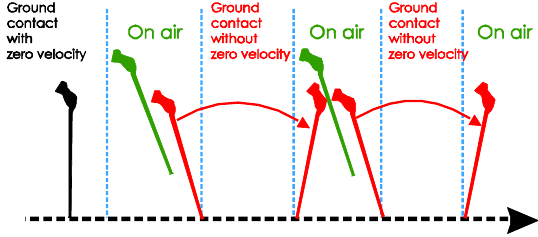
Figure 10. Standard cane’s movement patterns.